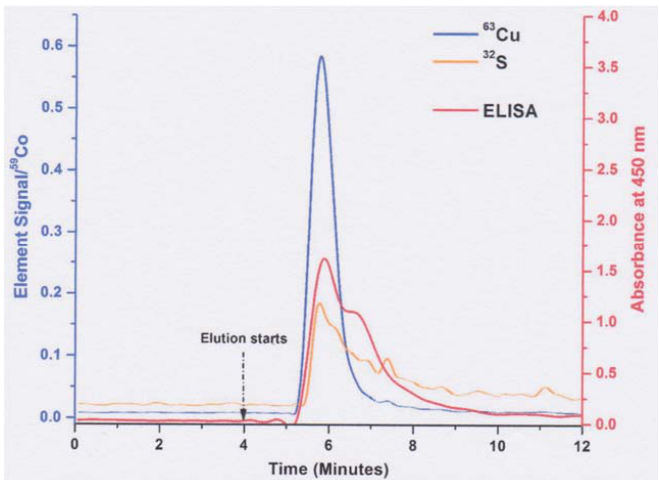
Figure 7. Immunoaffinity chromatography of human ceruloplasmin, coupled with ICP-MS to detect copper (blue line) and ELISA immunoassays to quantify ceruloplasmin protein (red line). Diluted blood serum was applied to the column to bind with the immobilized antibody against human ceruloplasmin, and proteins not binding to the antibody washing through. The graph shows what occurs when elution buffer is applied (glycine buffer, pH 2.2). The signal for 63 Cu is given relative to the 59 Co standard (left y ‐ axis); ELISA absorbance values are on the right y ‐ axis. The orange line is 32 S, which reflects the elution of proteins in general. Reprinted without changes, from Bernevic et al. [32], via the Creative Commons license (http//creativecommons.org/publicdomain/zero/1.0/).